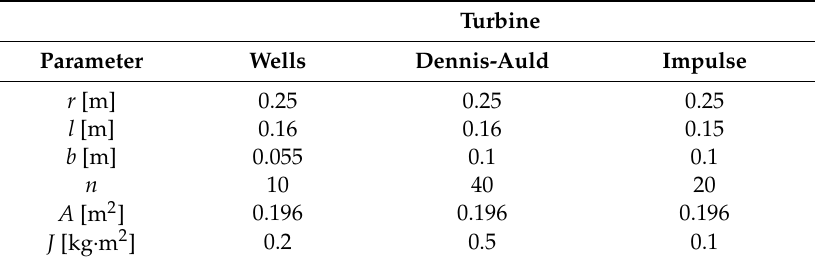
Figure 6. Simulink model with rotor and wind speeds as inputs, and power and torque at the shaft as outputs.